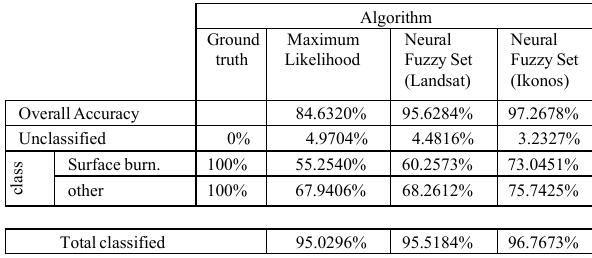
Algorithm Ground Maximum Neural Neural truth Likelihood Fuzzy Set Fuzzy Set (Landsat) (Ikonos)